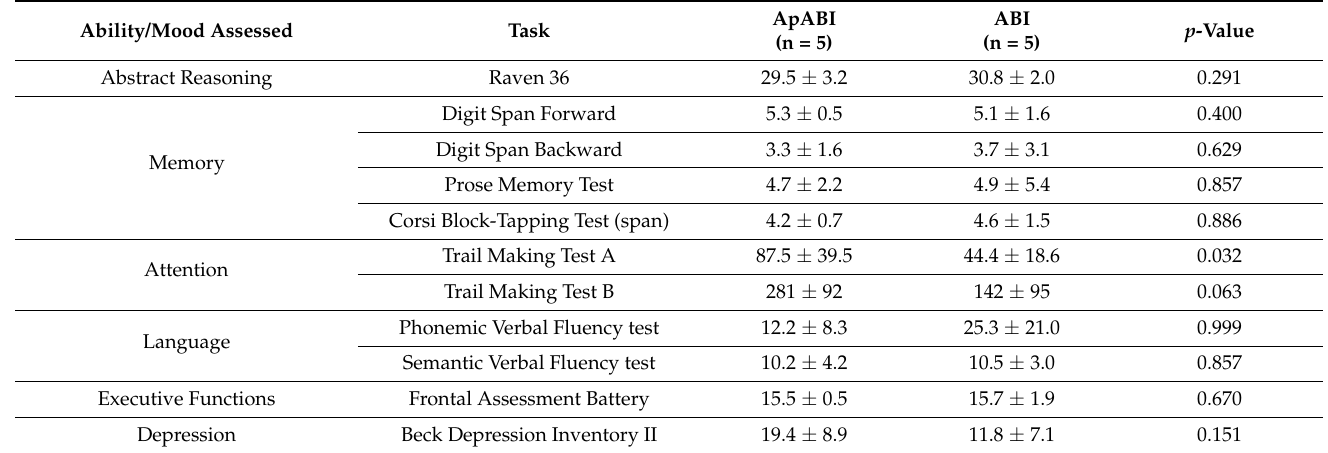
Table 2. Neuropsychological assessment and mood assessment.